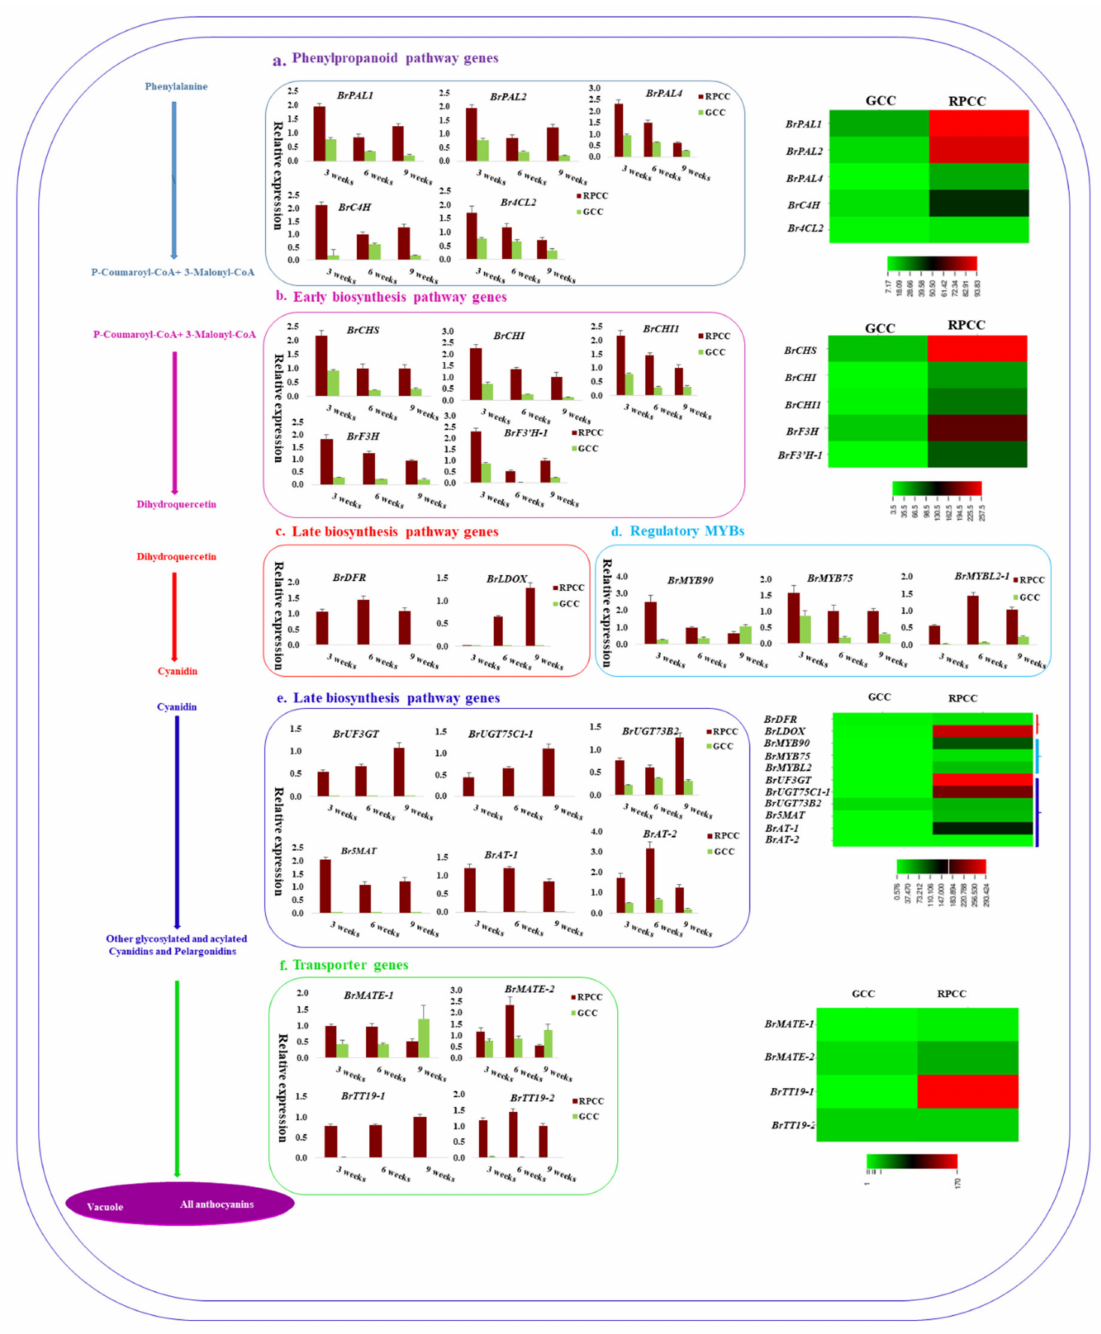
Figure 5. Validation of anthocyanin biosynthetic genes (ABGs) detected in transcriptome data by qRT-PCR analyses of reddish purple (RPCC) and green (GCC) leaf tissue samples. ( a ) Phenylpropanoid pathway genes; ( b ) early biosynthesis pathway genes; ( c ) and ( e ) late biosynthesis pathway genes; ( d ) regulatory MYB genes; and ( f ) transporter genes. Gene expression levels were normalized against that of Actin . Error bars are based on mean of three technical replicates. Schematic representation of anthocyanin biosynthetic pathway is shown in left corner. Heatmaps in middle and right corner indicate transcript abundance of